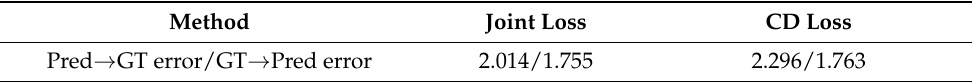
Figure 12. Comparison experiment of loss function. Table 6. Pred → GT error and GT → Pred error obtained via joint loss and CD loss as loss